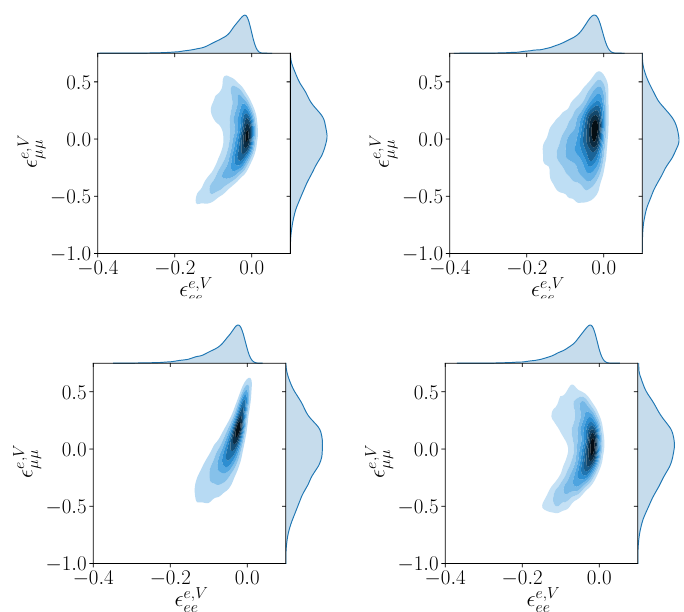
Figure 4 . Posterior kernel density contours and their marginals plotted for the (cid:15) e;V The joint distribution observations from MultiNest (top-left) are compared with 10 4 simulated samples drawn from (cid:12)ts for a Gaussian copula (top-right), a Gumbel copula (bottom-left), and an empirical copula (bottom-right). In each (cid:12)t, the 1-D marginals are reproduced well, but only the empirical copula can accurately reproduce the non-trivial dependency structure of the MultiNest observations in this